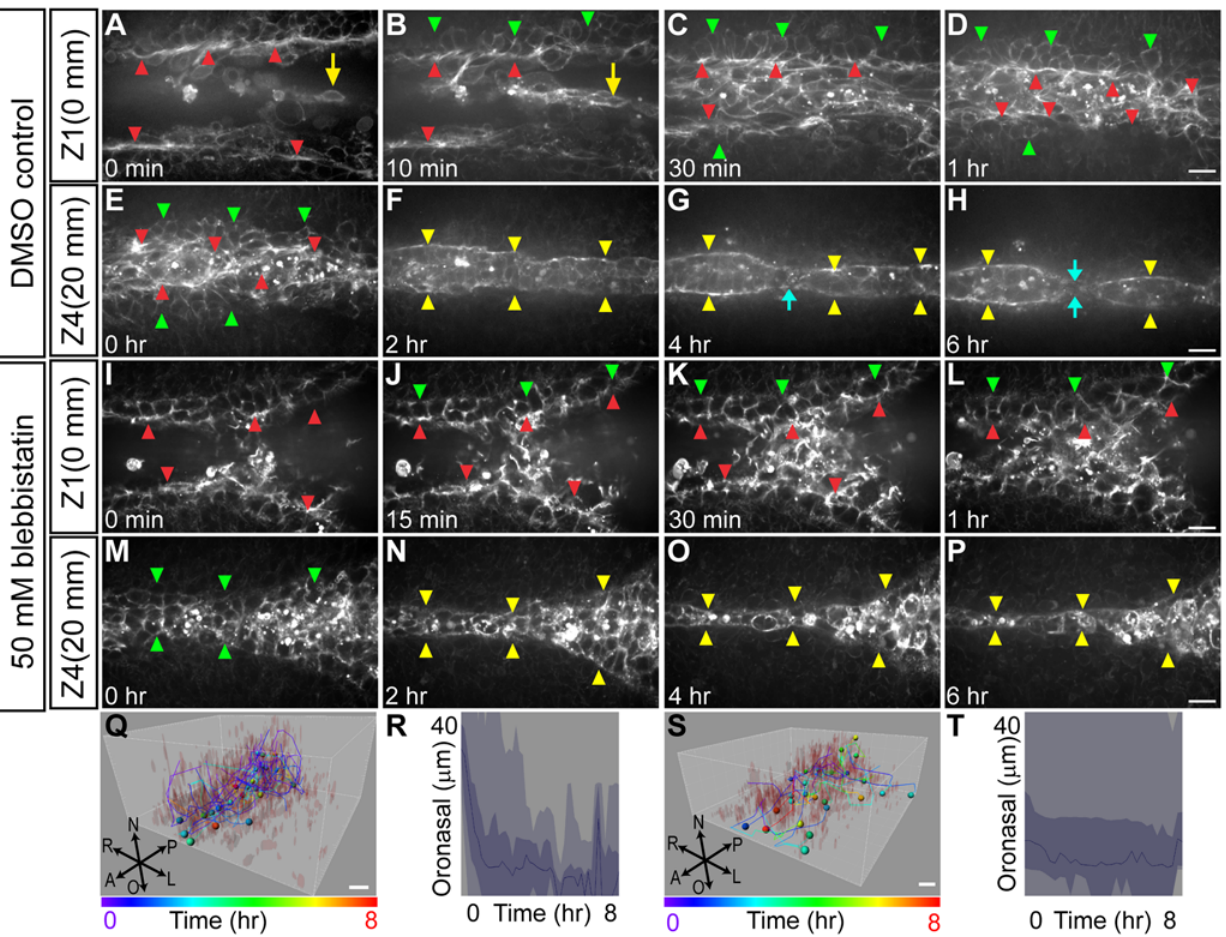
Fig 5. Confocal live imaging of actin cytoskeletal dynamics during palatal fusion. (A – D) Time-lapse imaging of Lifeact-mRFPruby palate explant culture reveals prominent multicellular actin cables at the leading edge (red arrowhead) of the palatal shelves as they initiate their closure. In superficial (oral) optical sections (A – D), epithelial cells displaced from deeper layers were observed between the leading edges of the palatal shelves prior to convergence of the shared MES (yellow arrow). The lateral edges of the MES are marked with green arrowheads. (E – H) Imaging at deeper optical sections reveals multicellular actin cables that bound the MES laterally as it broke apart (blue arrows). Scale bar, 20 μ m. (I – P) Inhibition of NMII with 50 μ M blebbistatin causes defects in epithelial convergence and failure to organize actin cables at the palatal shelf leading edge (red arrowheads) (I – J). (M – P) Imaging of deeper sections shows a thinning and stretched MES, but without lateral actin cables (yellow arrowheads) and the seam did not break as in control. (Q – T) 3-D tracking and vantage plots show oronasal displacement of MES cells in control (Q, R) but not blebbistatin-treated palatal explants (S, T). Scale bar, 10 μ m.